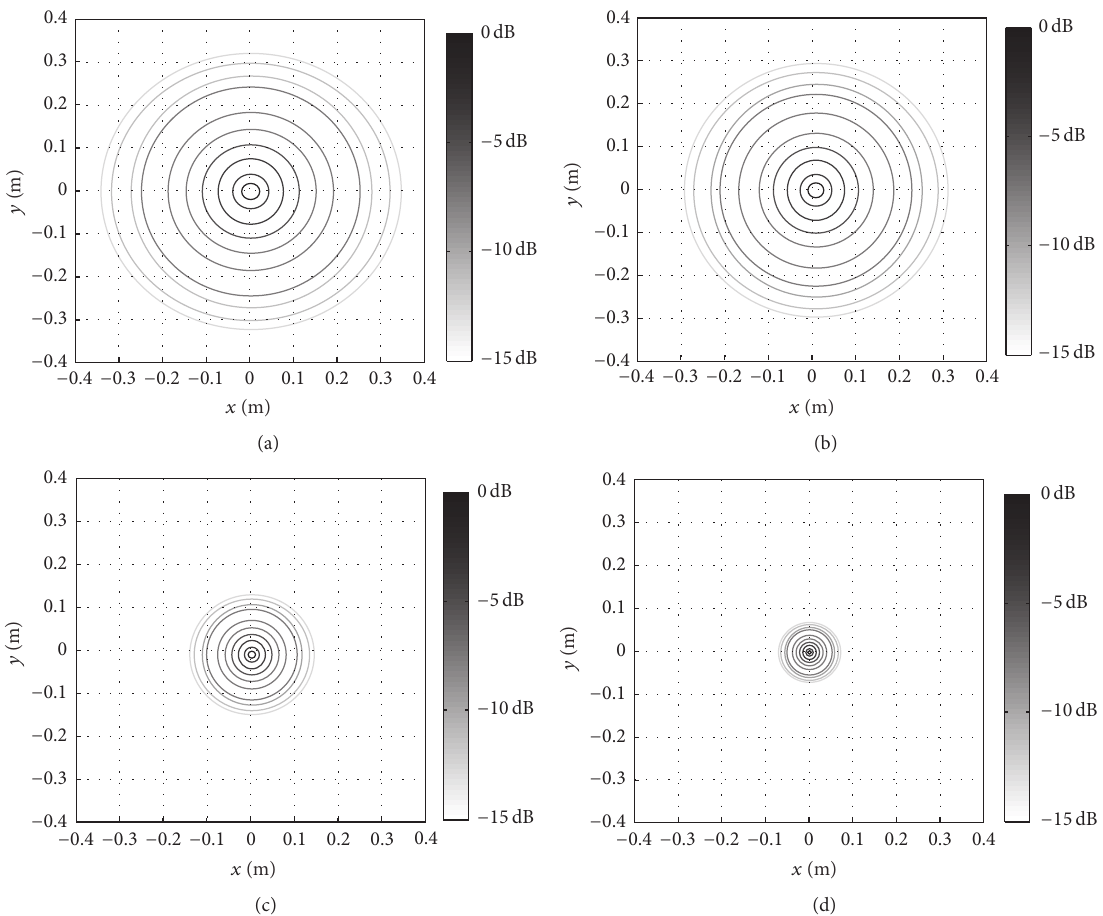
Figure 6: Contour diagram of sound pressure on the reconstruction surface (1500Hz). (a) WBH. (b) iWBH. (c) IFESM, V = 1 . (d) IFESM, V = 5